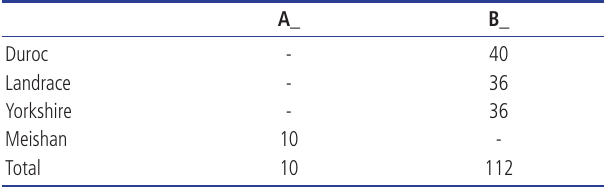
Table 3. Frequency of genotypes of OGT among the Duroc, Landrace, Yorkshire, and Meishan pigs